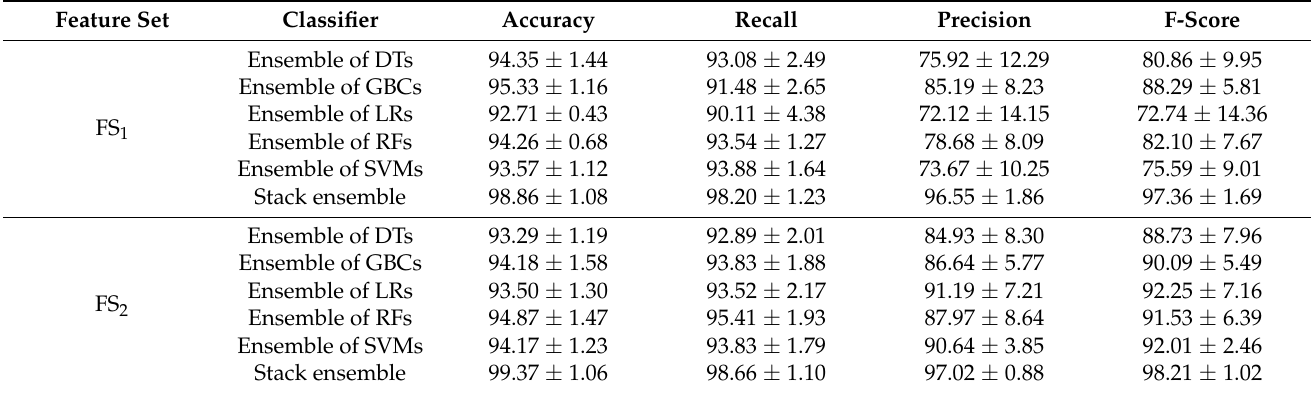
Table 5. Macroaverage of performance measures for different classifiers considering different fea- ture sets.